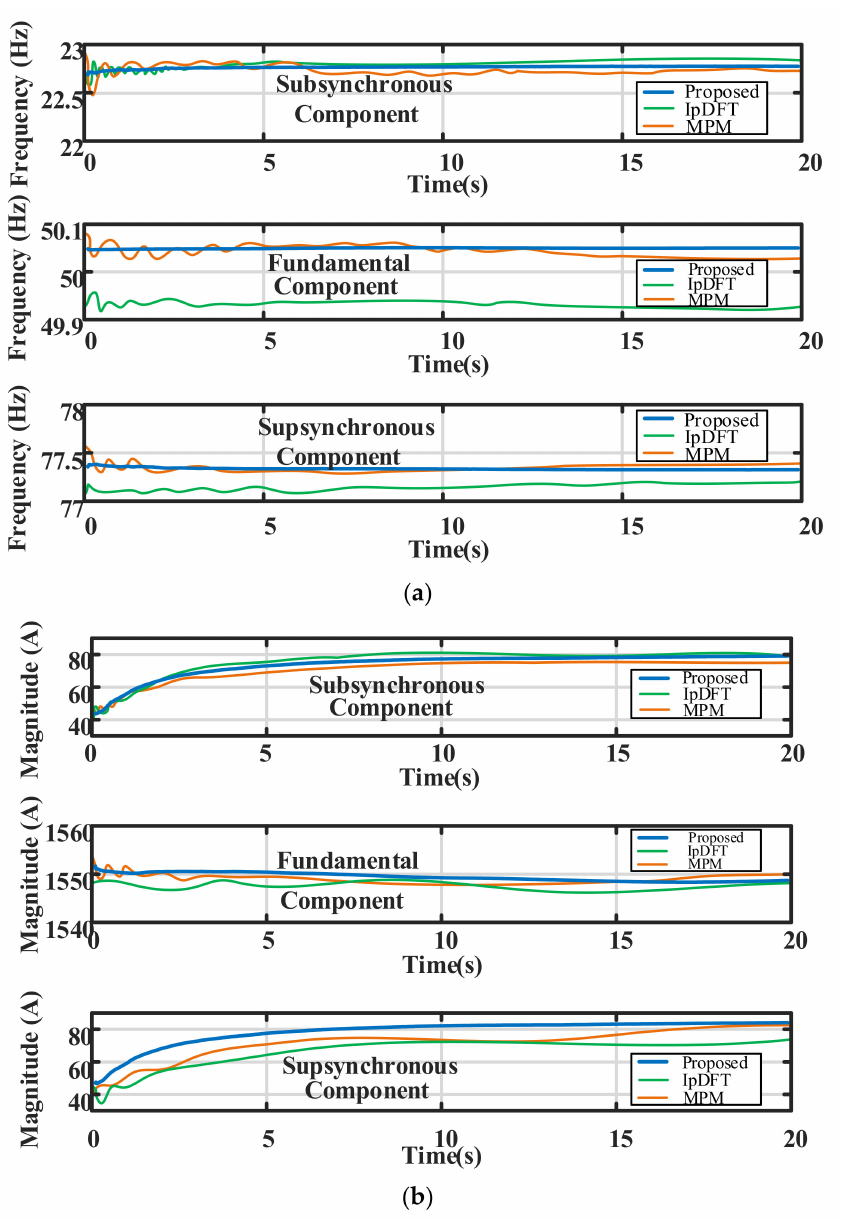
Figure 17. Results of parameter identification. ( a ) Frequency identification results, ( b ) Amplitude identification